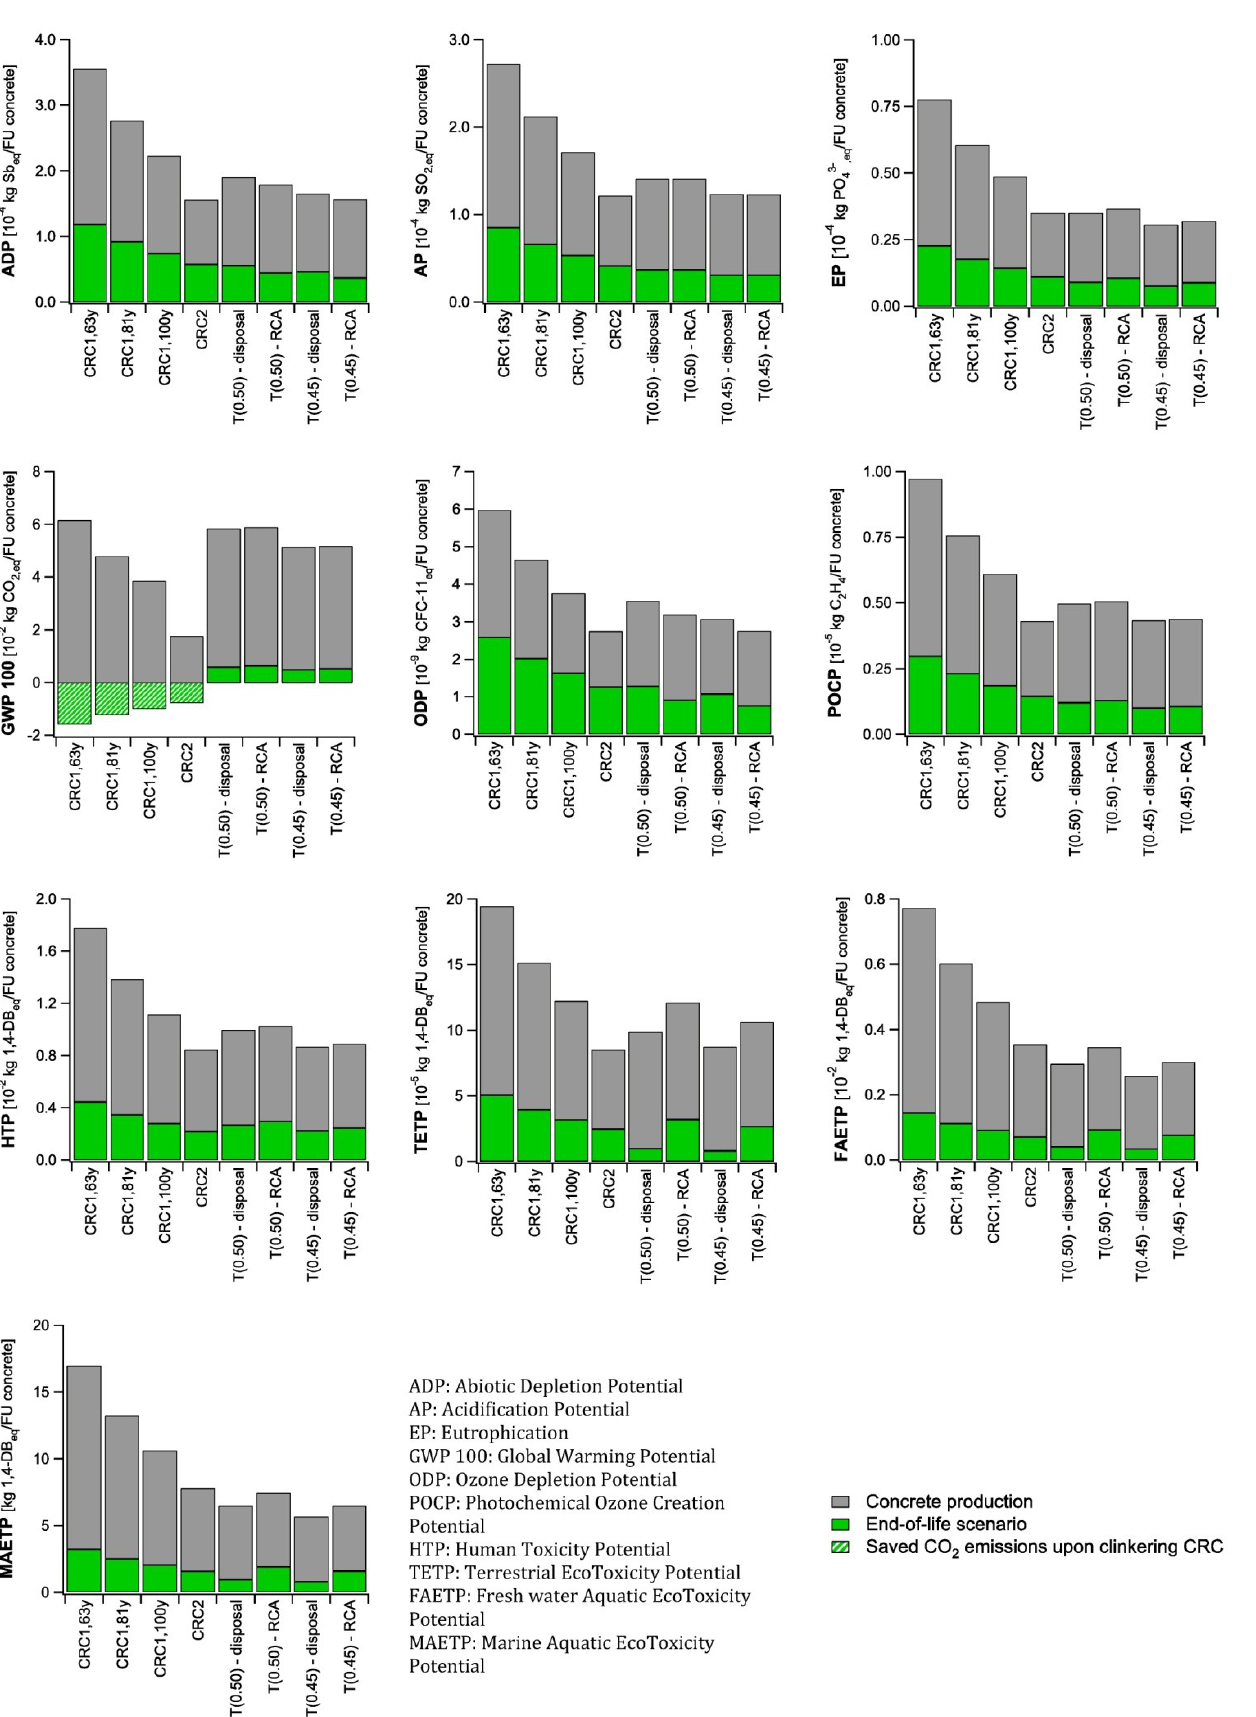
Figure 5. Cradle-to-cradle Life Cycle Impact Assessment of 1 FU